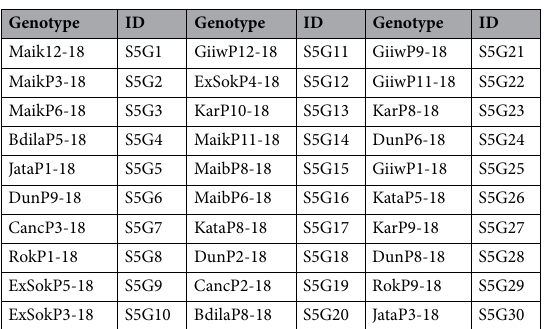
Table 1. The thirty selected Bambara groundnut accession used in this study. Maik = Maikai; Bdila = Bildillali; Jata = Jatau; Dun = Duna; Canc = Cancaraki; Rok = Roko; Giiw = Giiwa; Kar = Karu; Maib = Maibergo; Kata = Katawa; Exsoko = Exsokoto.